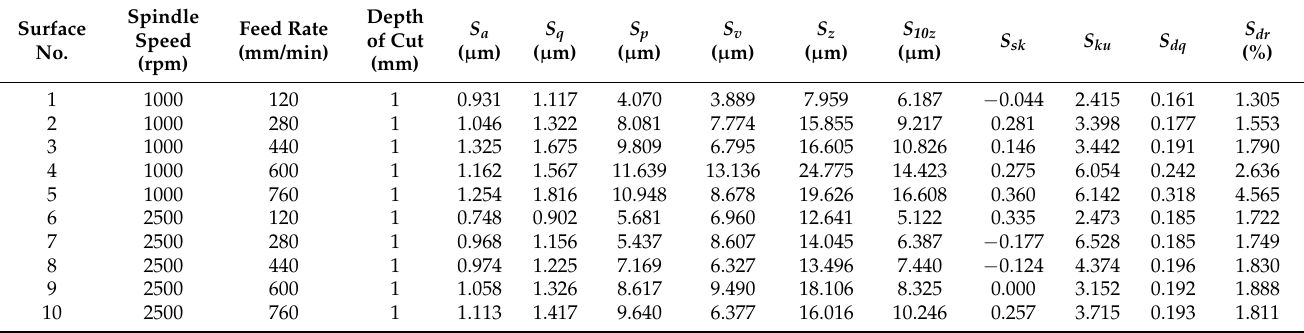
Table 1. Tabulation of machining parameters and 3D roughness parameters of each surface [10].